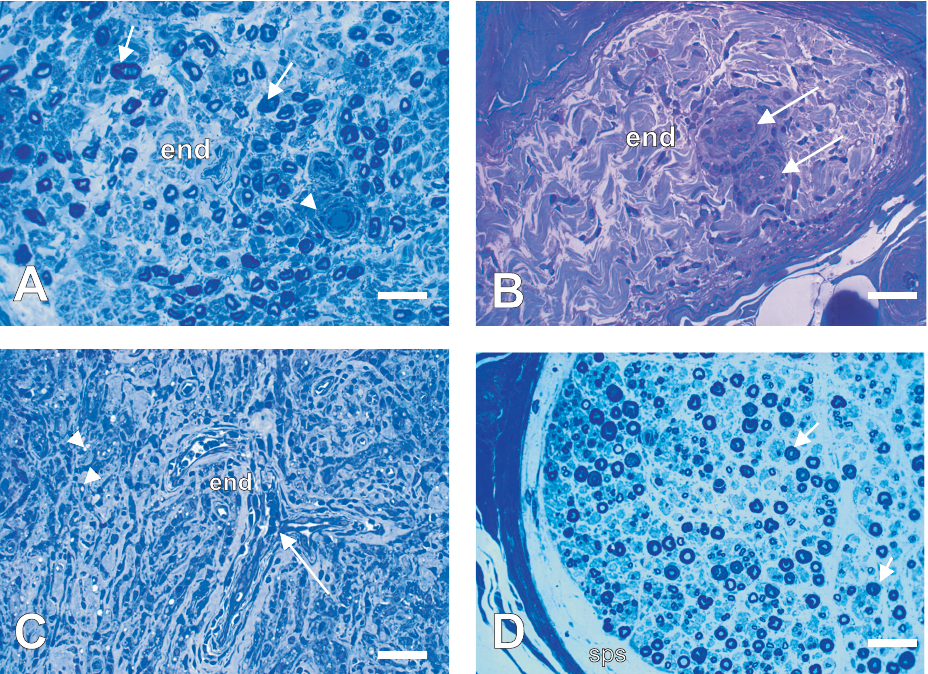
Figure 3. Histopathological exami- nation of semithin sections of in- flammatory infiltrate and loss of my- elinated fibers. A , Nerve fascicle with a reduced number of myeli- nated fibers (arrows) and a few in- flammatory cells surrounding thick- ened microvessels (arrowhead) in the endoneurial compartment (end). B , Nerve fascicle with complete absence of myelinated fibers and few macrophages surrounding thickened endoneurial microves- sels (arrows) in the endoneurial compartment (end). C , Endoneu- rium (end) of a nerve fascicle with a dense inflammatory infiltrate composed of vacuolated macro- phages (arrowheads) and lympho- cytes surrounding a prominent, branched microvessel (arrow). Note the absence of myelinated fi- bers. D , Nerve fascicle with a re- duced number of myelinated fibers and enlarged subperineurial space (sps). Atrophic axons can also be seen (arrows). Scale bar = 40 µm for all